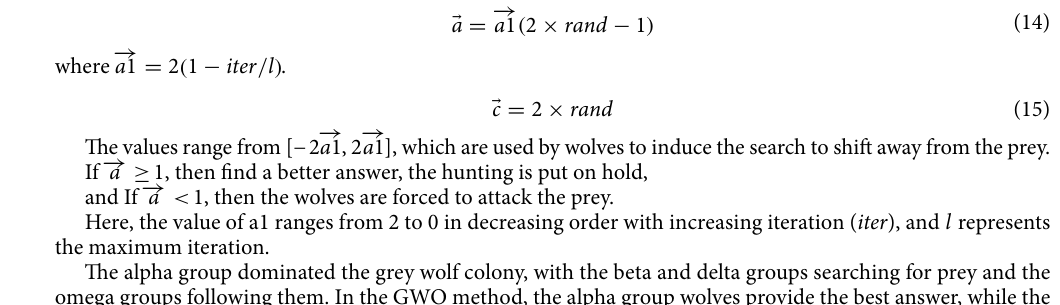
x p is the prey position, where (cid:31) formulated as: